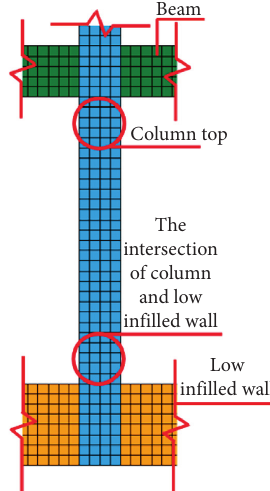
Figure 48: Initial state of first-floor side column.